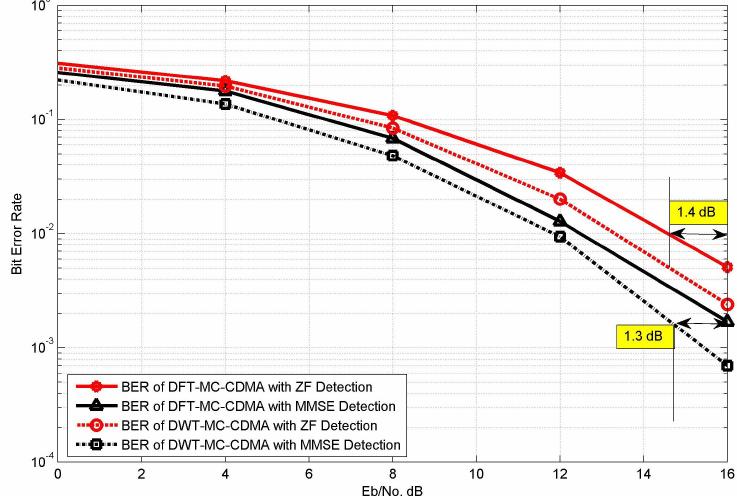
Figure 11. Comparative analysis of DFT and DWT-based MC-CDMA